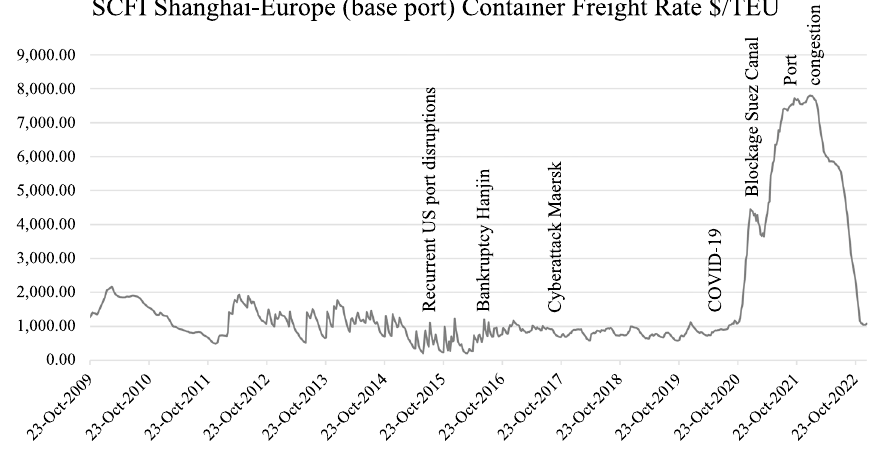
Fig. 3 Evolution of Sea freight. Source : own composition based on Clarkson Research